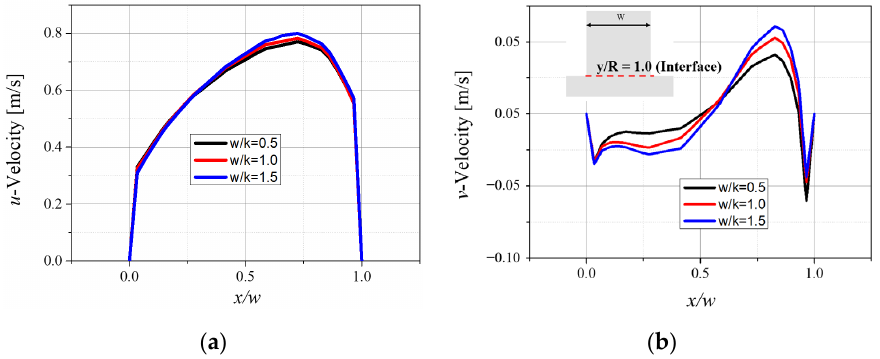
Figure 11. Velocity distribution at interface for different w / k . ( a ) U-velocity distribution at interface line for different w / k , ( b ) v -velocity distribution at interface line for different w / k. Figure 12 shows (a) is the pressure contour at the groove, (b) is the streamline at the lower right corner of the groove, (c) is the velocity vector at the lower right corner of the groove, and (d) is the streamline of the main flow. In the pressure contour, the high pressure at the lower right corner occurs because the part of the main flow impacts the lower right corner of the groove. After a collision, some of the flow enters the grooves again and rotates, with any remaining flow beyond the groove affecting the main flow. The same result can be confirmed in Stel. [10]. In the main flow’s streamline, it is affected by the flow coming out of the groove following collision.